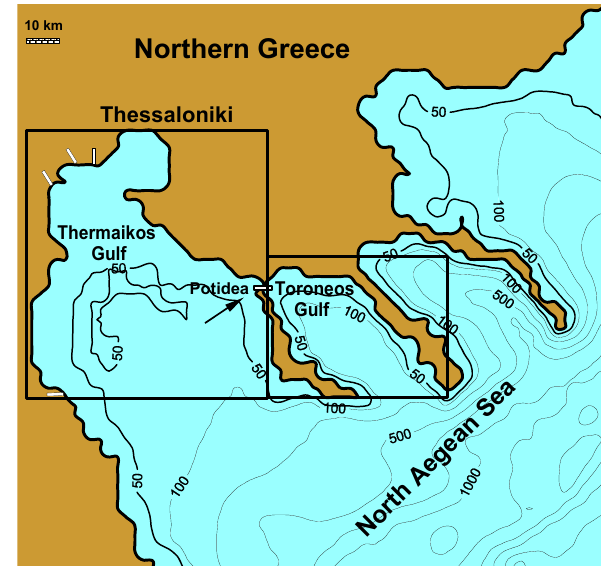
Fig. 2 The greater study area with the two gulfs and the particular area of the Potidea channel Fig. 2. The greater study area with the two gulfs and the particular (the arrow marks the channel) area of the Potidea channel (the arrow marks the